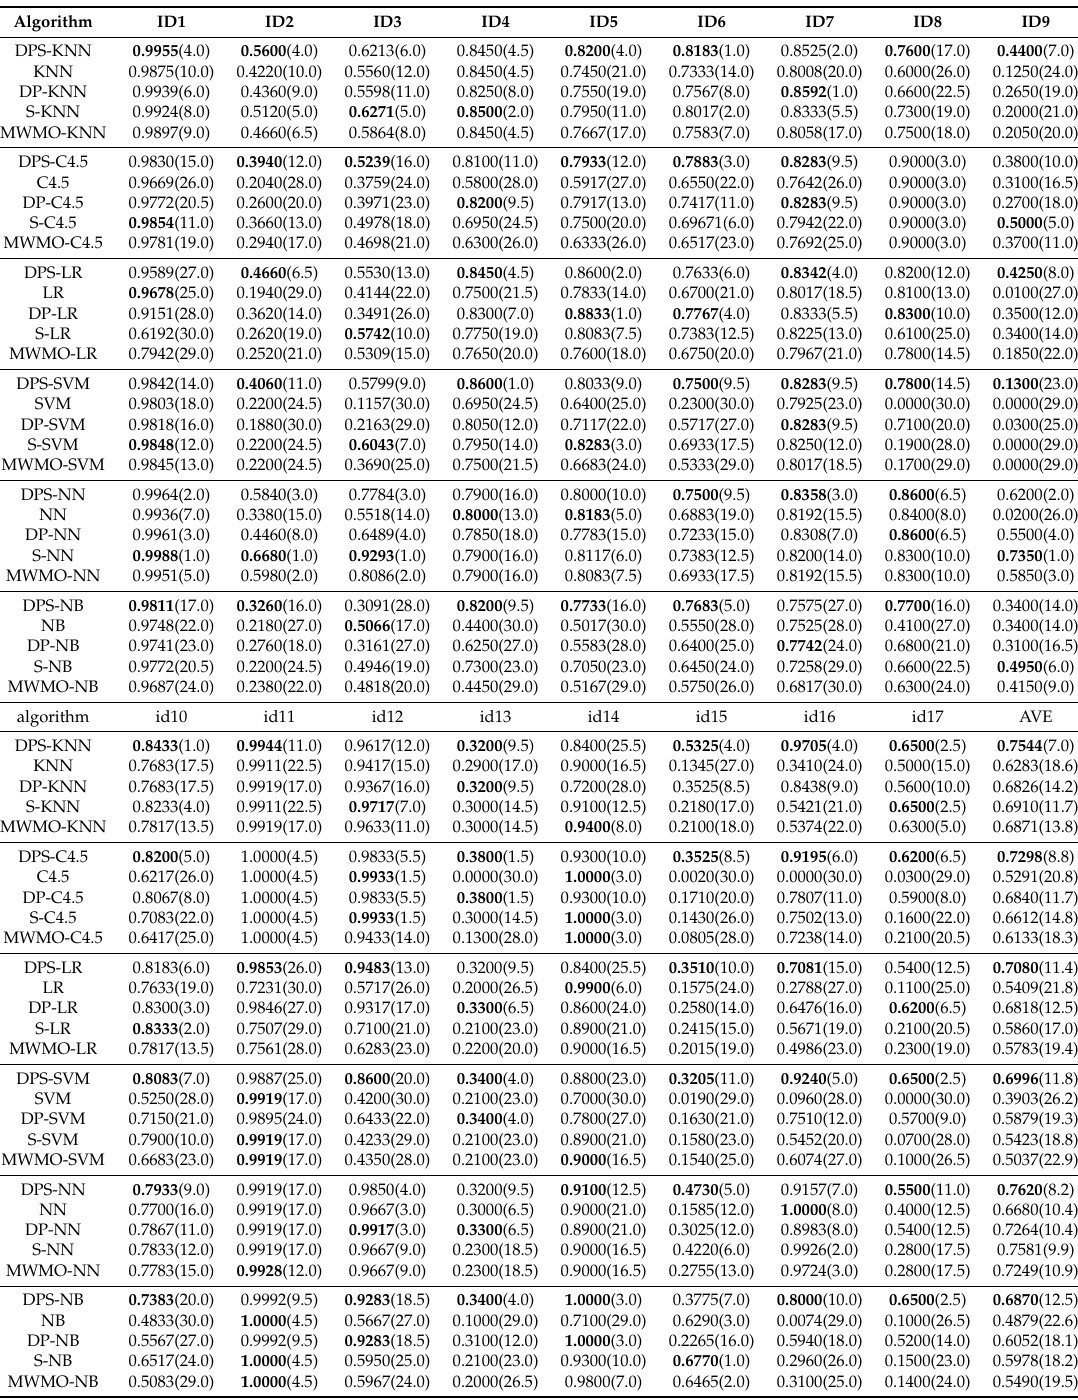
Table 3. Experimental results of models on Recall